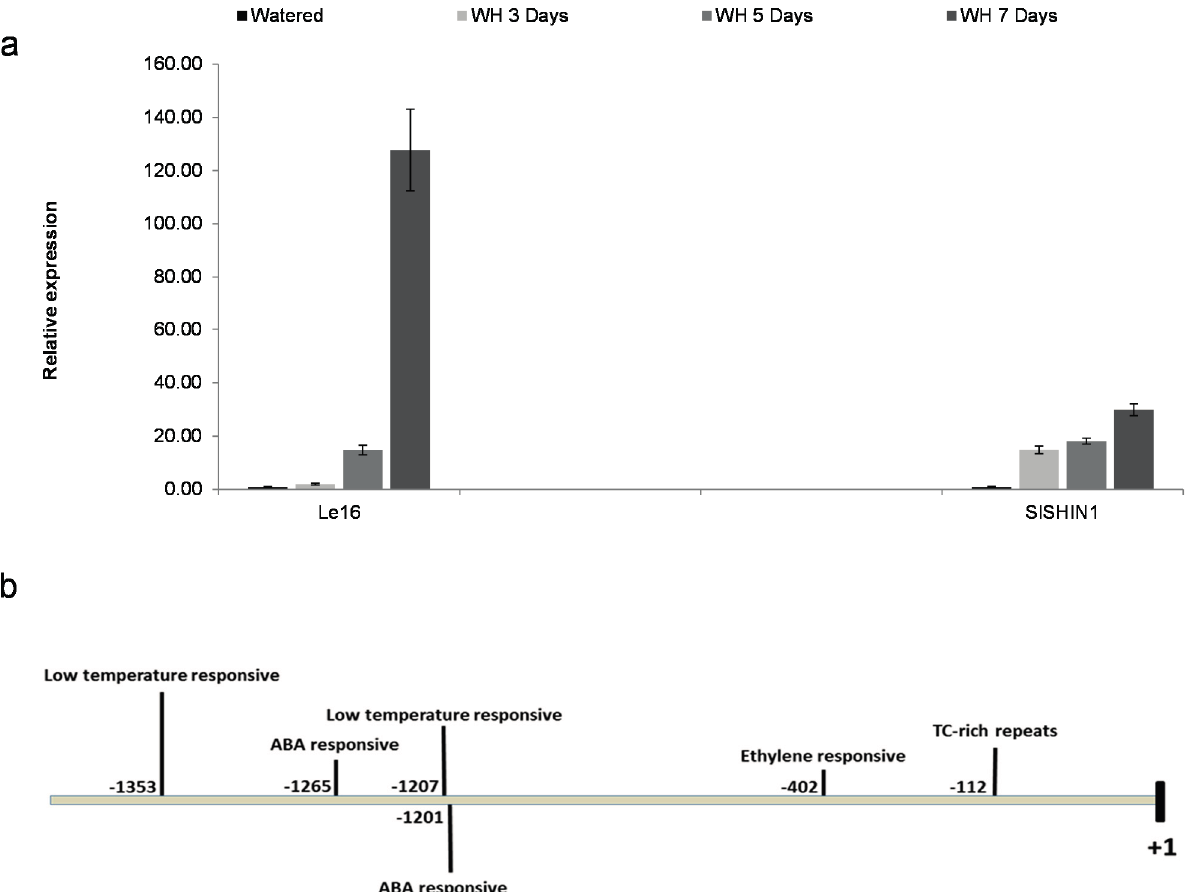
Figure 2. ( a ) Gene expression analysis of SlSHN1 in response to drought conditions. Tomato Moneymaker plants were subjected to water withholding (WH) conditions for 3, 5 and 7 days and compared to well-watered plants (control). The stress responsive Le16 ( Solyc10g075090 ) gene was included as a control. The bars are standard deviations (SD) of three technical repeats; ( b ) Characteristics of the promoter region of SlSHN1 in tomato. Distribution of major known stress-related cis -elements in the first 1500 bp of the SlSHN1 promoter region as identified using PlantCARE cis -element